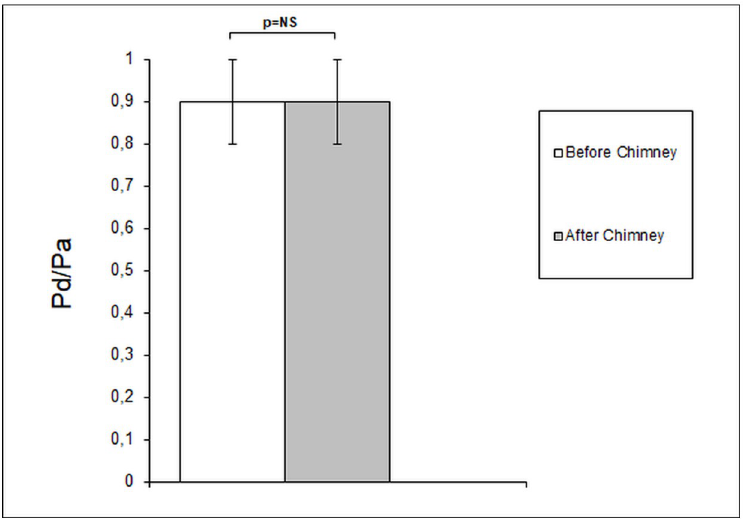
Fig 3. Changes in Pd/Pa before and after chimney implantation. No difference in Pd/Pa ratio before and after chEVAR